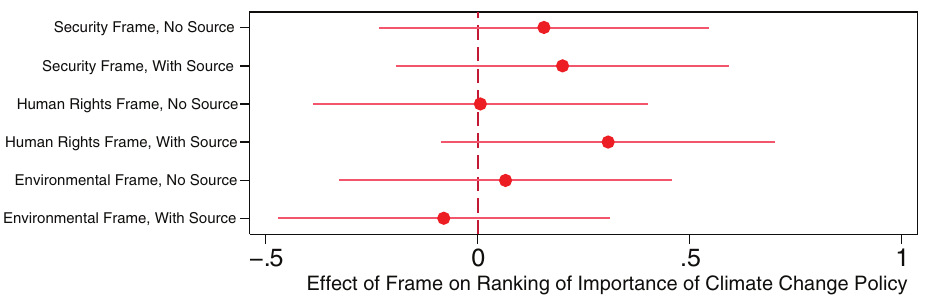
Fig 3. Climate change frames and rankings of the importance of climate change policy. Note: Horizontalbars indicate90% confidenceintervals.